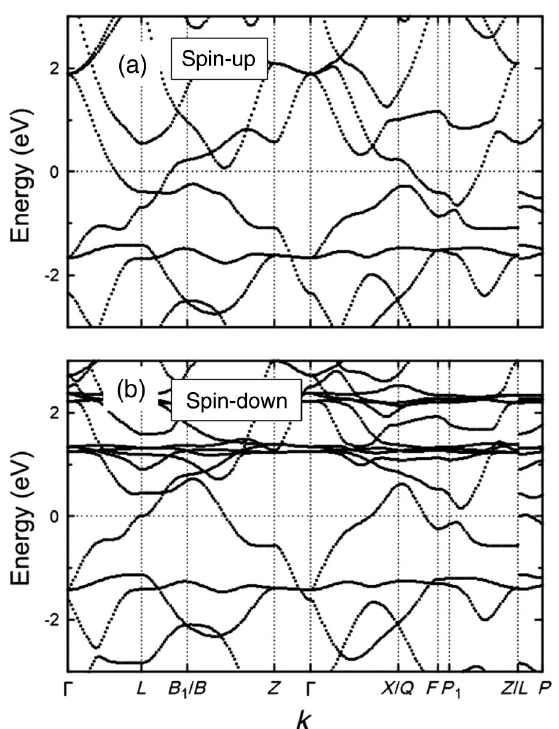
FIG. 12. Calculated band structure of Dy 2